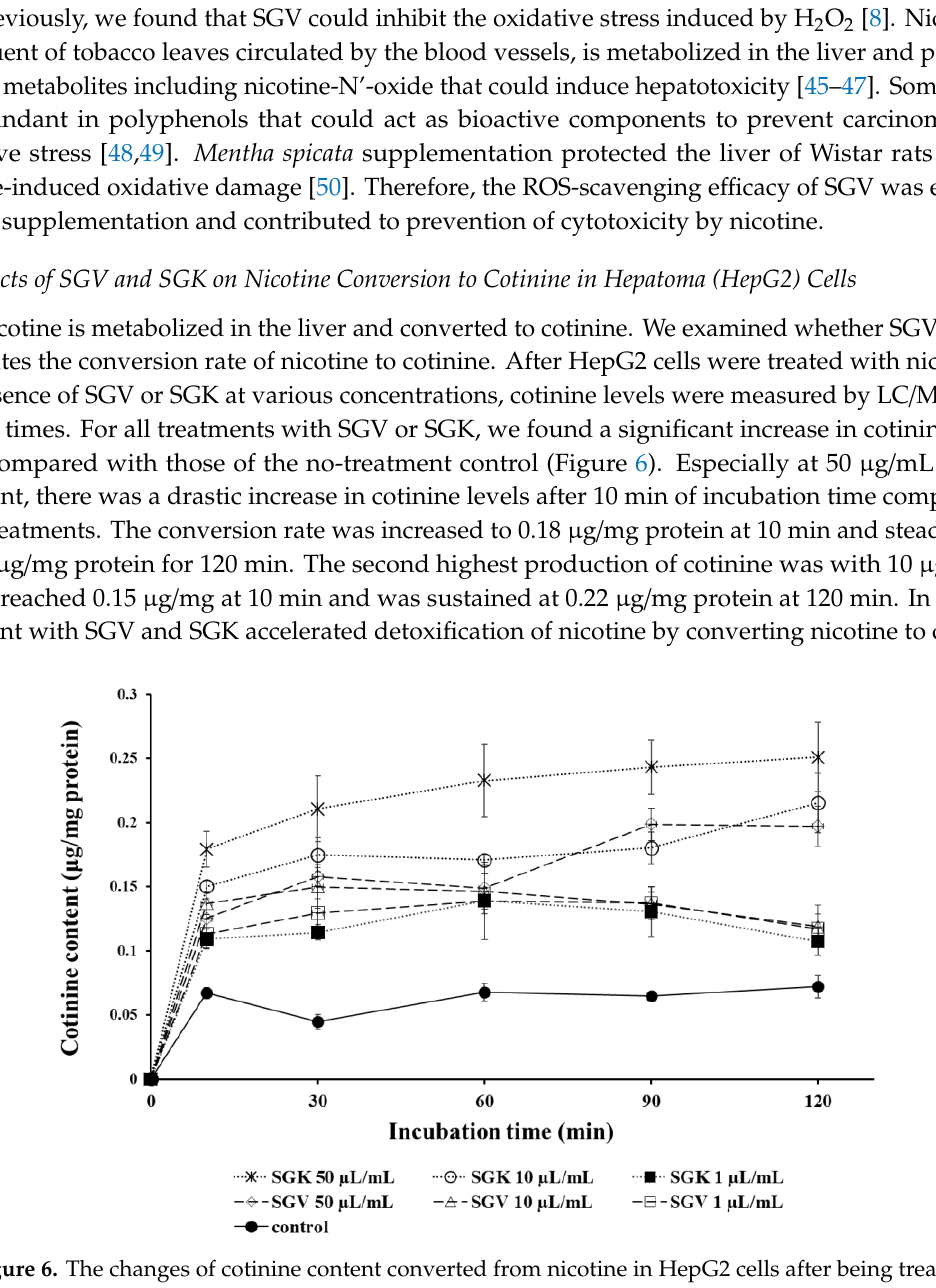
Figure 6. The changes of cotinine content converted from nicotine in HepG2 cells after being treated with various concentrations of SGV and SGK during 120 min, which is the half-life of nicotine.